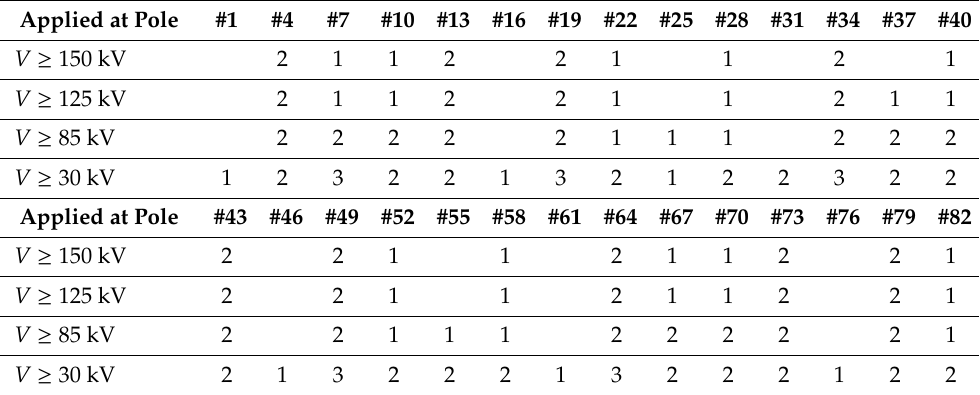
Table 12. Number of transformers with at least one phase reaching the critical overvoltage level. Case 4, wet arsenic-impregnated poles, sub-configuration C4.1 with no grounded intermediate poles. Applied at Pole